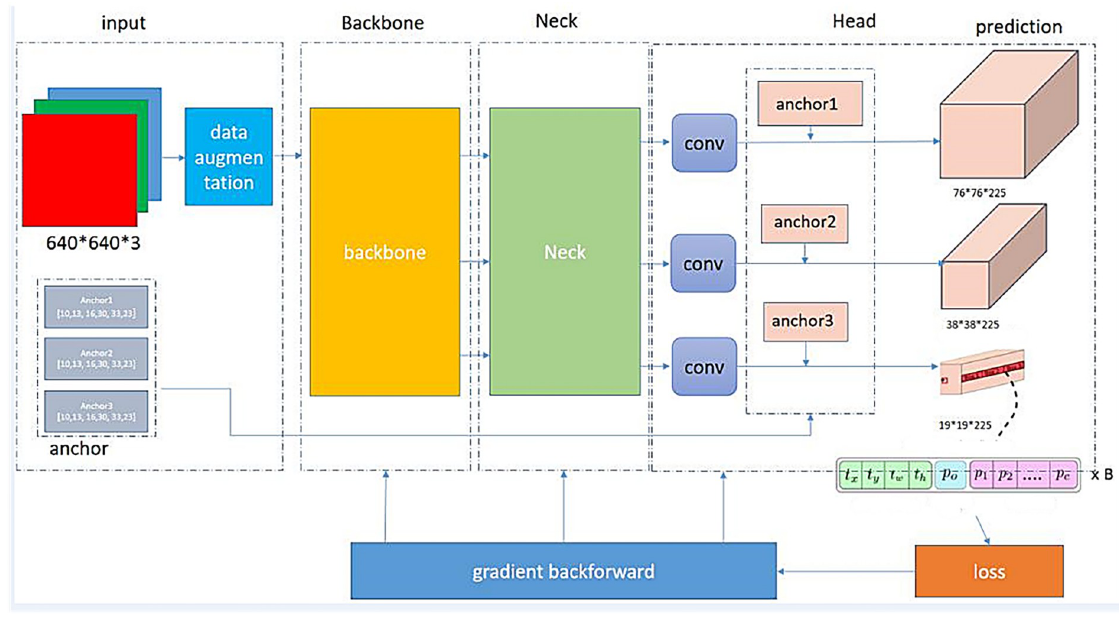
Fig 3. Network structure of the YOLO